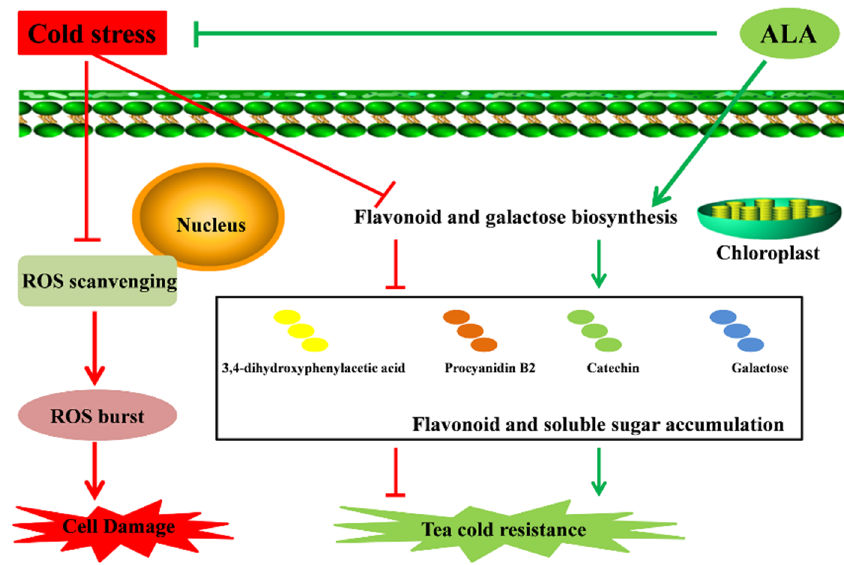
Figure 5. Possible pathways for cold stress tolerance in tea improved by ALA.